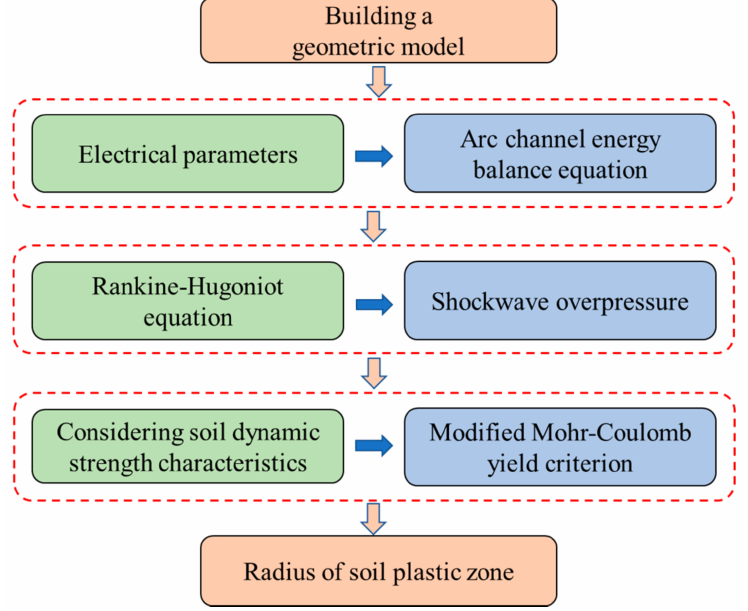
Figure 8. The flowchart of mathematical model and analytical